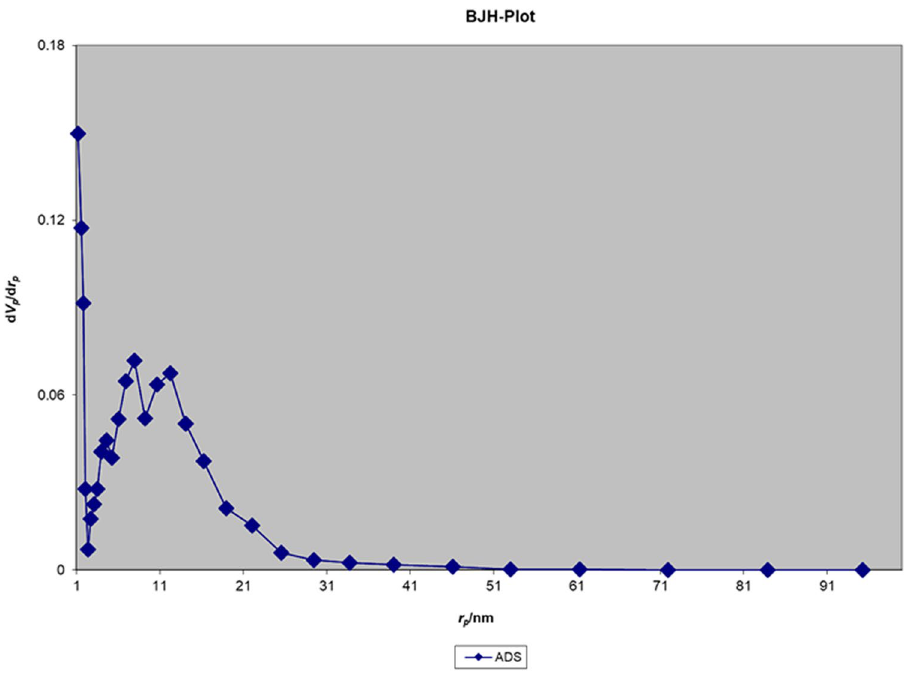
Figure 11. BJH pore size distribution isotherm of the Fe 3 O 4 @Void@m.SiO 2 nanomaterial before adsorption process.